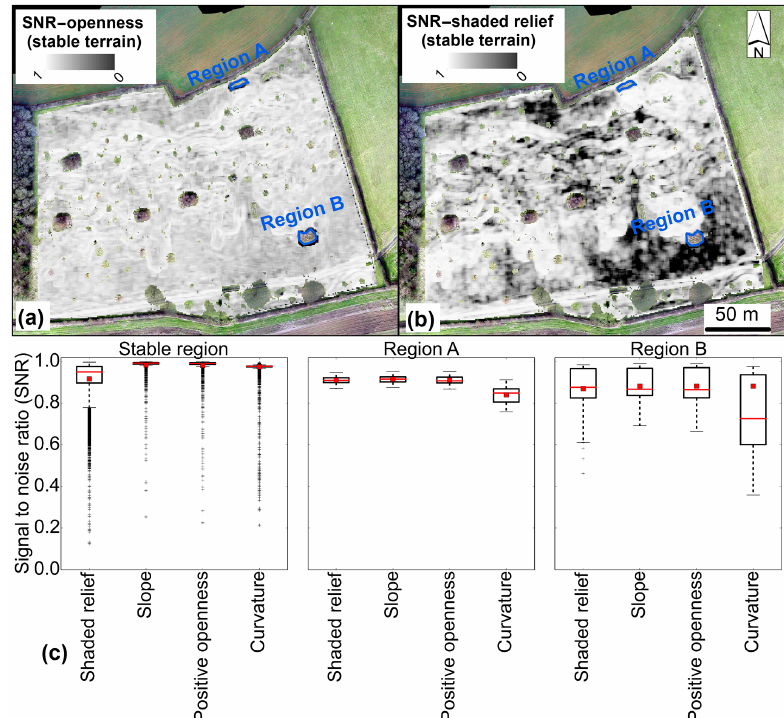
Figure 1. Signal-to-noise ratio (SNR) maps of stable terrain derived from COSI-Corr with (a) openness and (b) shaded relief superimposed over the December 2014 orthomosaic. (c) Box plots of SNRs for stable terrain in Regions A and B, as derived from the implementation of COSI-Corr with shaded relief, slope, openness and curvature applied to synthetic datasets. The median is displayed as a red line, the mean as a red rectangle, the whiskers as black horizontal lines and the outliers as black crosses (Peppa et al.,